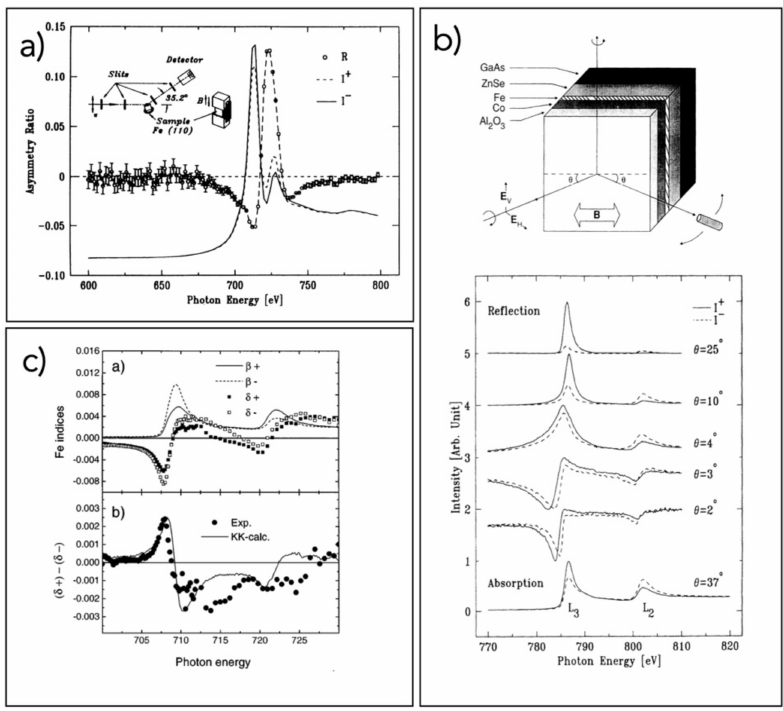
Figure 2. ( a ) Specular reflectivity in p–polarized light on an Fe film of 35 Å, with magnetic field applied perpendicular to the scattering plane; the reflectivity curves obtained with opposite fields and the asymmetry ratio R are shown; the asymmetry ratio is particularly pronounced across the Fe 2p absorption edge (reprinted figure with permission from [33]. Copyright (1990) by the American Physical Society); ( b ) scattering geometry on a GeAs/ZnSe/Fe/Co/Al 2 O 3 multilayer and dichroic reflectivity curves at different grazing angles; the dichroic absorption at the Co edge is also shown (reprinted figure with permission from [34]. Copyright (1994) by the American Physical Society); ( c ) imaginary part ( β ) and decrement of the real part ( δ ) of the complex refractive index at the Fe 2p edge obtained by coupling absorption and reflectivity at resonance and at the Bragg angle from a Fe/V superlattice (+ and − signs refer to opposite magnetizations) and comparison between δ + – δ - and the Kramers–Krönig (KK) transformation of β + − β − (reprinted figure with permission from [37]. Copyright (1998) by the American Physical